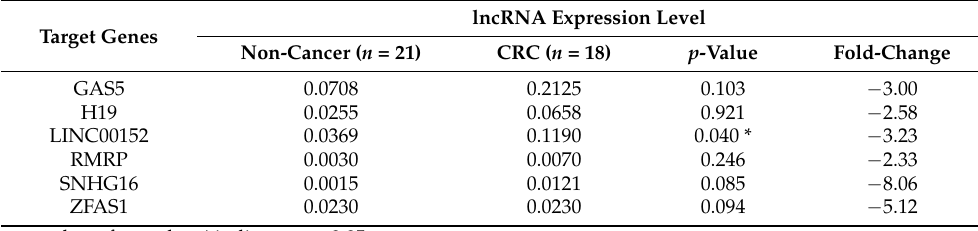
Table 3. The fold-change for lncRNAs GAS5, H19, LINC00152, RMRP, SNHG16, and ZFAS1 expres- sion level in non-cancer individuals and CRC patients.